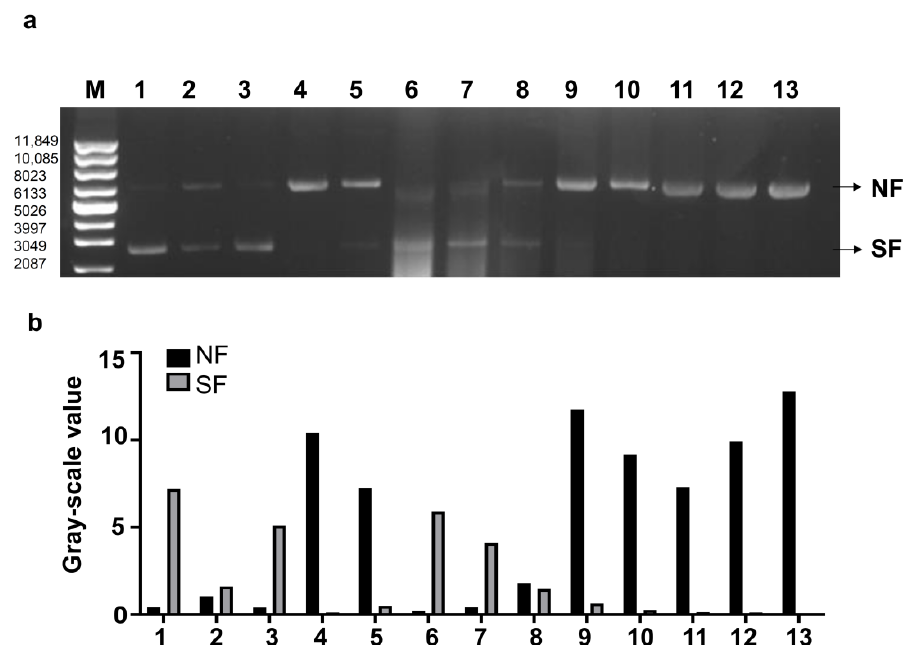
Figure 5. Potential of rTbprx-1 to protect supercoiled DNA from cleavage in a MCO system using DNA nicking assays. ( a ) Protection of supercoiled DNA cleavage by rTbprx-1. ( b ) Gray-scale value of nicked and supercoiled DNA from different lanes in ( a ). M: Supercoiled DNA Ladder Marker. lane 1: pUC18 DNA in water, incubated at 37 °C for 2.5 h; lane 2: pUC18 DNA incubated with 2 mM DTT only; lane 3: pUC18 DNA incubated with 0.2 mM FeCl 3 only; lane 4: pUC18 DNA in the MCO reaction mixture; lane 5: pUC18 DNA in the MCO reaction mixture with bovine serum albumin (0.5 mg/mL); lanes 6–13: pUC 18 DNA in the MCO reaction mixture with varying concentrations of rTbprx-1 (0.9, 0.45, 0.225, 0.1125, 0.05625, 0.028125, 0.0140625, 0.00703125 mg/mL). NF: nicked form; SF: supercoiled form.